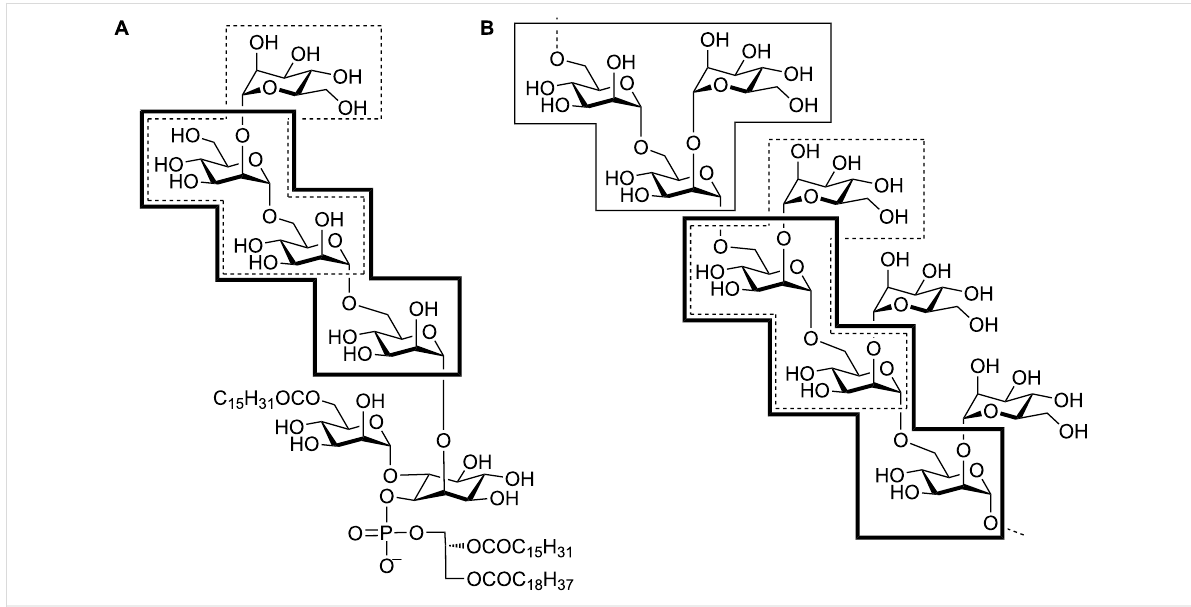
Figure 1: Chemical structures of (A) a representative PIM, AcPIM 5 and (B) a mannan fragment of LM from mycobacteria. Boxes denote the relation- ship of PIMs and LM to trisaccharide fragments synthesized in this study.